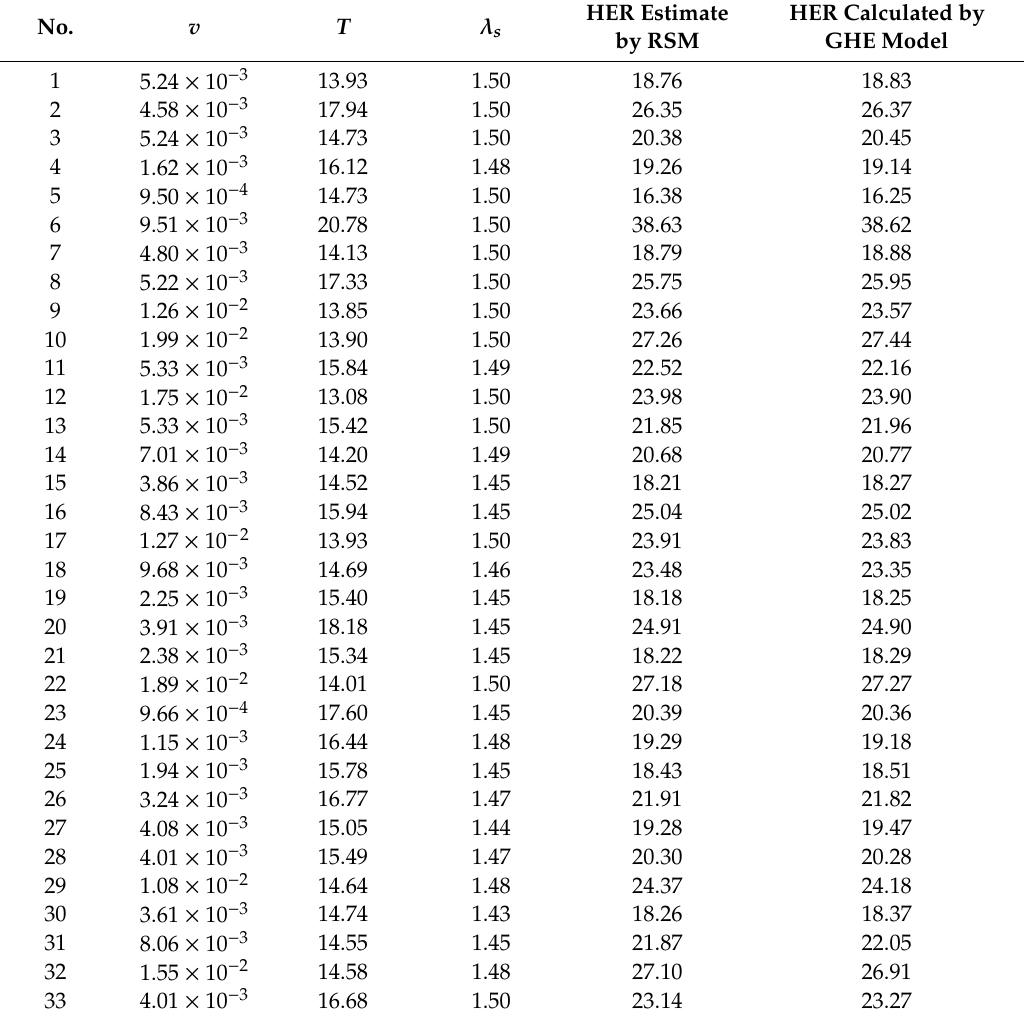
Table 4. Relational data between the three parameters and HER at 33 GHE models. HER calculated by the GHE model is based on Kaneko et al.